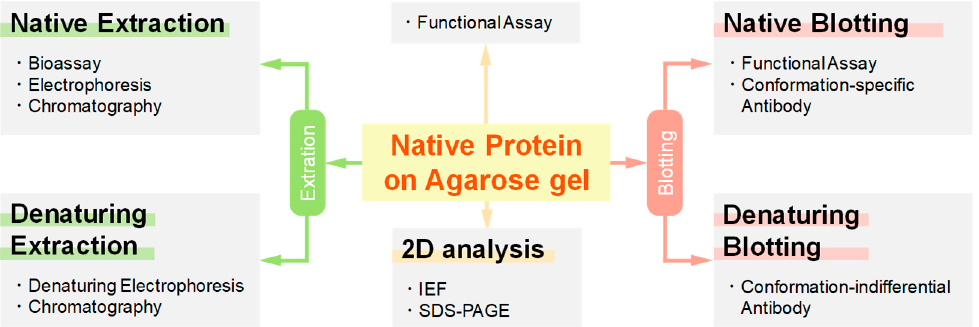
Figure 5. Schematic illustration of several application of agarose native gel electrophoresis. IEF, isoelectric focusing.